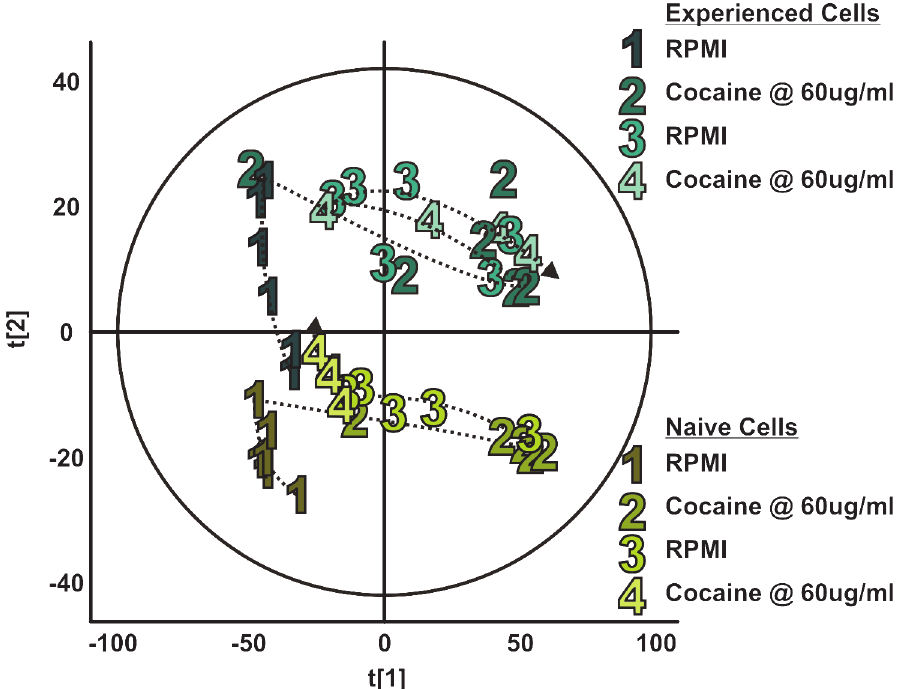
Fig 5. Exometabolomic profiles of na ï ve and cocaine-experienced Jurkat T cells from online cellular analysis. Walking principal component analyses of exometabolomic profiles of na ï ve (shades of yellow) and cocaine-experienced (shades of turquoise) Jurkat T cells were constructed following online cellular analysis. Each numerically labeled data point represents a 9-minute column elution, with six data points collected per step (all marked with the step number and connected in order of collection with the dotted line). In steps 1 and 3, both cell populations received plain RPMI. In steps 2 and 4, both received cocaine in RPMI at 60 μ g/mL. As profiles switch from RPMI to cocaine exposure, the data points move towards the right and vice versa, with the exception of na ï ve cell step 4, which stays closer to step 1. Further analysis of the data reveals this inconsistency may be explained by the death of the cells. Data were grouped not only based on the experimental step, but also by the experience level of the cells, as the cells receiving a 4-hour pre-incubation in cocaine group separately from those that did not receive this